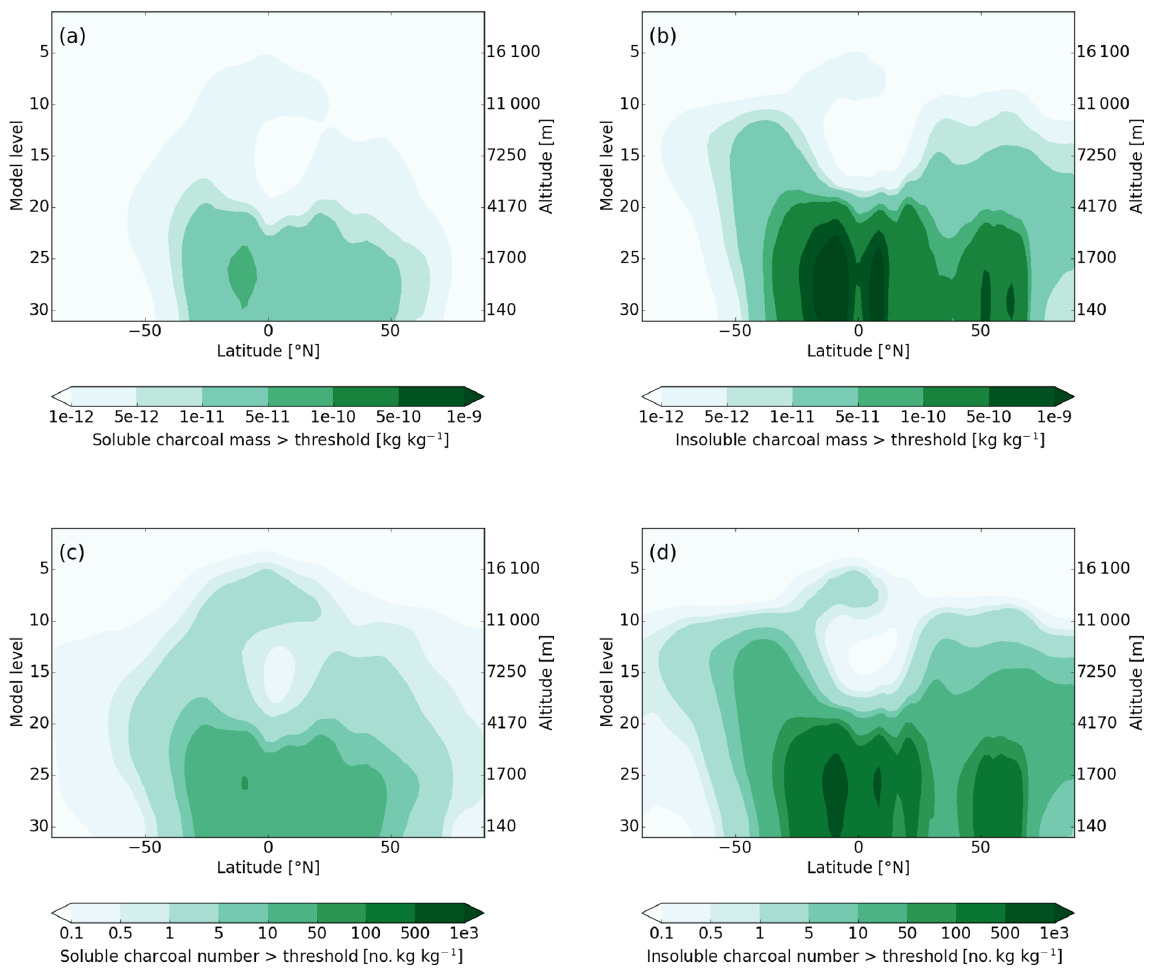
Figure 6. Ten-year zonal average of the charcoal mass concentration above the threshold radius ( r eq = 4 . 9µm) in (a) the soluble and (b) the insoluble giant mode and of the number concentration of (charcoal) particles above the threshold radius in (c) the soluble mode and (d) the insoluble giant mode (using an emission number geometric mean radius of r eq = 5µm and a charcoal density of 0 . 6g cm − 3 ). The right y axis shows to which altitude the model layers approximately